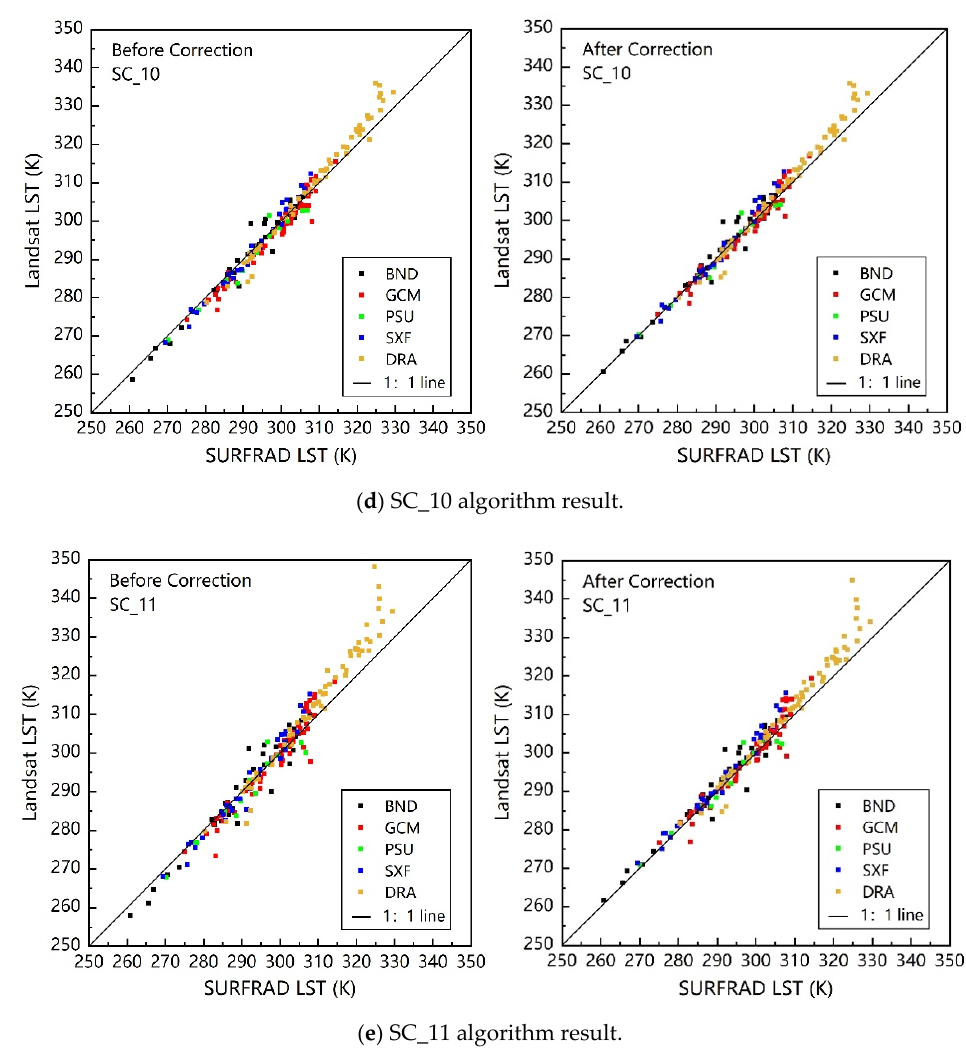
Figure 5. Comparison of Landsat 8 retrieved LST (Landsat LST) with ground LST (SURFRAD LST) over different sites before and after the stray light correction. ( a ) is for the SW_Du algorithm, ( b ) is for the SW_Rozenstein algorithm, ( c ) is for the SW_JM algorithm, ( d ) is for the SC_10 algorithm, and ( e ) is for the SC_11 algorithm.